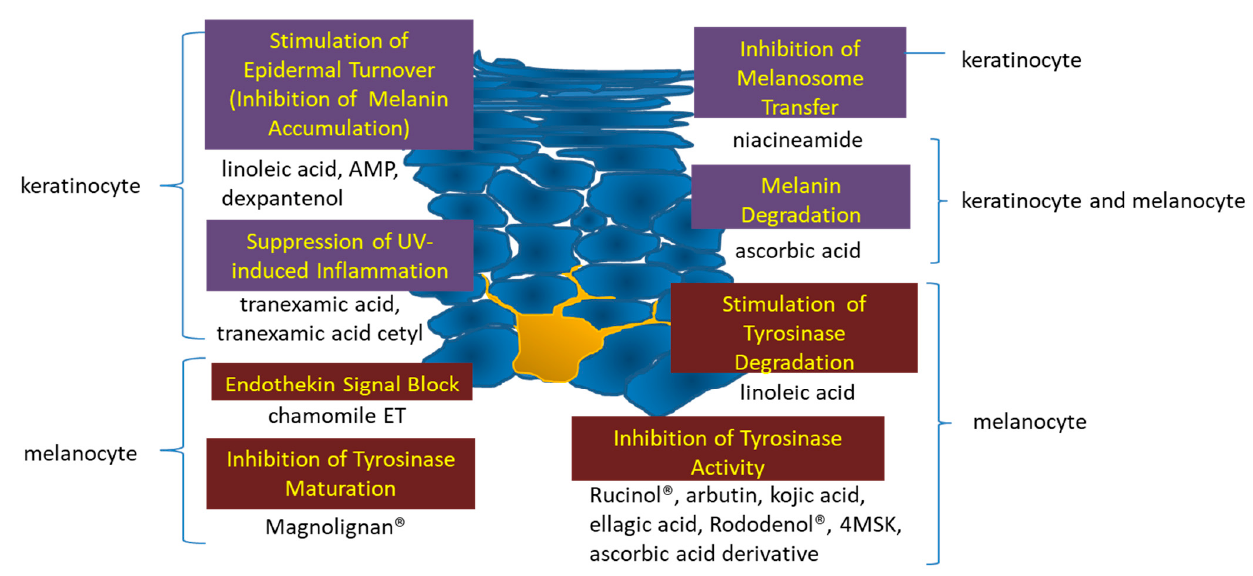
Figure 3. Point of action of skin-lightening active ingredients on the